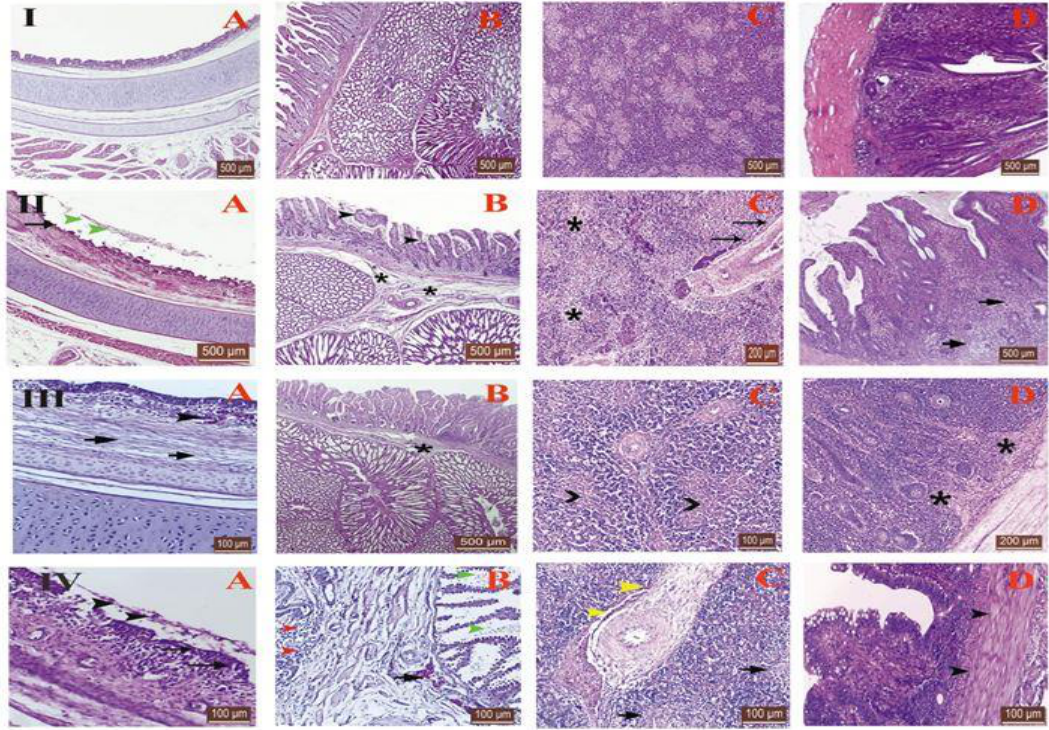
Fig. 6: Photomicrographs for histological sections of the trachea, proventriculus, spleen, and cecal tonsil of experimental groups (I, II, III, and IV) H&E stain, bar indicates magnification. Group (I) (A) trachea, (B), Proventriculus, (C) Splenic sections and (D) cecal tonsils, they showed normal histological structure. Group (II) (A) Trachea showed severe haemorrhage (black arrow) and severe cellular desquamation (green arrowhead), (B) Proventriculus showed severe haemorrhage, extensive epithelial cell degeneration (black arrowhead), and lymphocytic infiltration (black star), (C) Splenic section showed thickening of blood vessels wall (black arrow) and diffuse lymphoid follicles depletion (black star), (D) Section of cecal tonsils showed necrosis and lymphoid depletion (black arrow). Group (III) (A) Trachea showed deciliation (black arrowhead) and infiltrated lymphocyte (black arrow), (B) Proventriculus showed epithelial cell degeneration and lymphocytic infiltration (black star), (C) Splenic section showed mild to moderate lymphocytic degeneration (black arrowhead), (D) Section of cecal tonsils showed mild lymphocytic depletion (black star). Group (IV) (A) Trachea showed prominent epithelial desquamation (black arrowhead) and hyperplasia (black arrow) (B) Proventriculus showed lymphocytic infiltration (red arrowhead) and increased accumulated gland secretions (green arrowhead). (C) Splenic section showed lymphoid depletion (black arrow) and thickening of blood vessels wall (yellow arrowhead). (D) Section of caecal tonsils showed focal necrotic lymphoid follicle (black